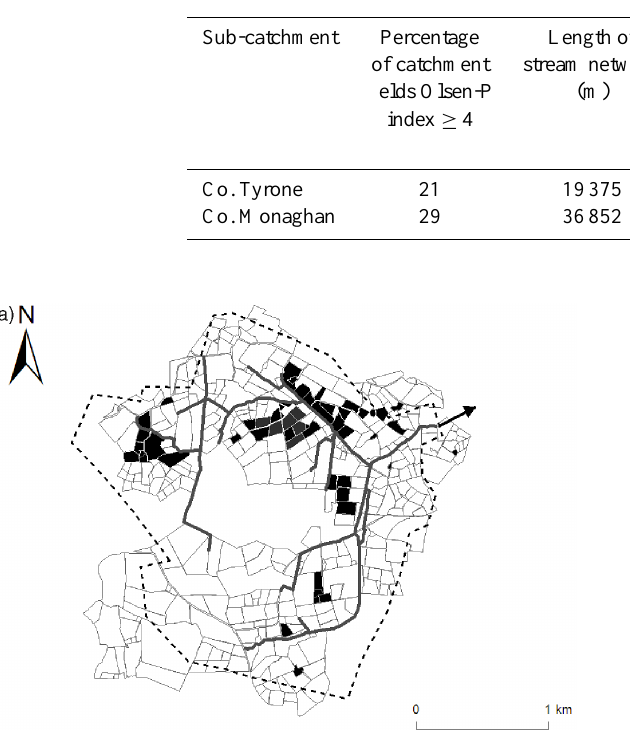
Table 2. Length of stream network potentially impacted in each catchment by Olsen-P index 4 fields (critical source areas).